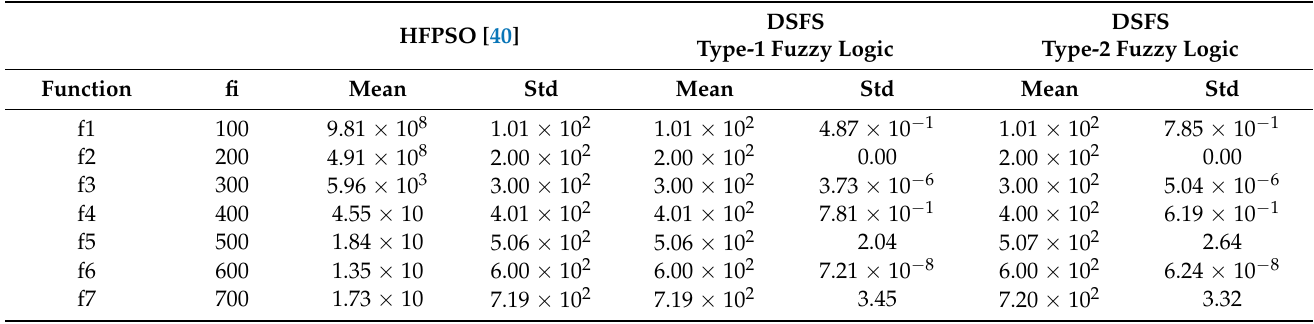
Table 6. HFPSO vs. DSFS results with 10